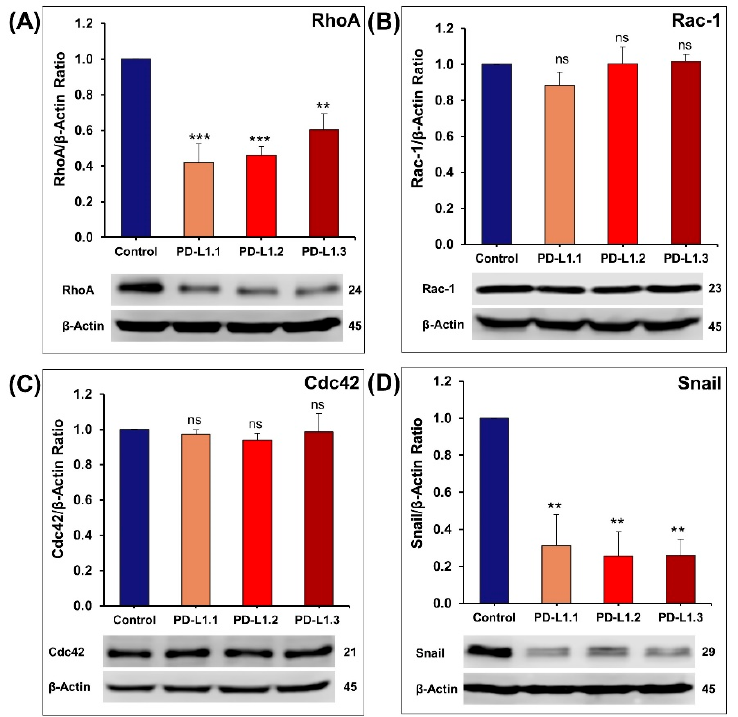
Figure 9. Quantification of western blot showing the effect of PD-L1 knockout on the expression of RhoA ( A ), Rac-1 ( B ), Cdc42 ( C ), and Snail ( D ). Experiments were repeated at least three times. Results are expressed as means ± S.E.M. ** p < 0.01. *** p < 0.001. ns—non-significant.